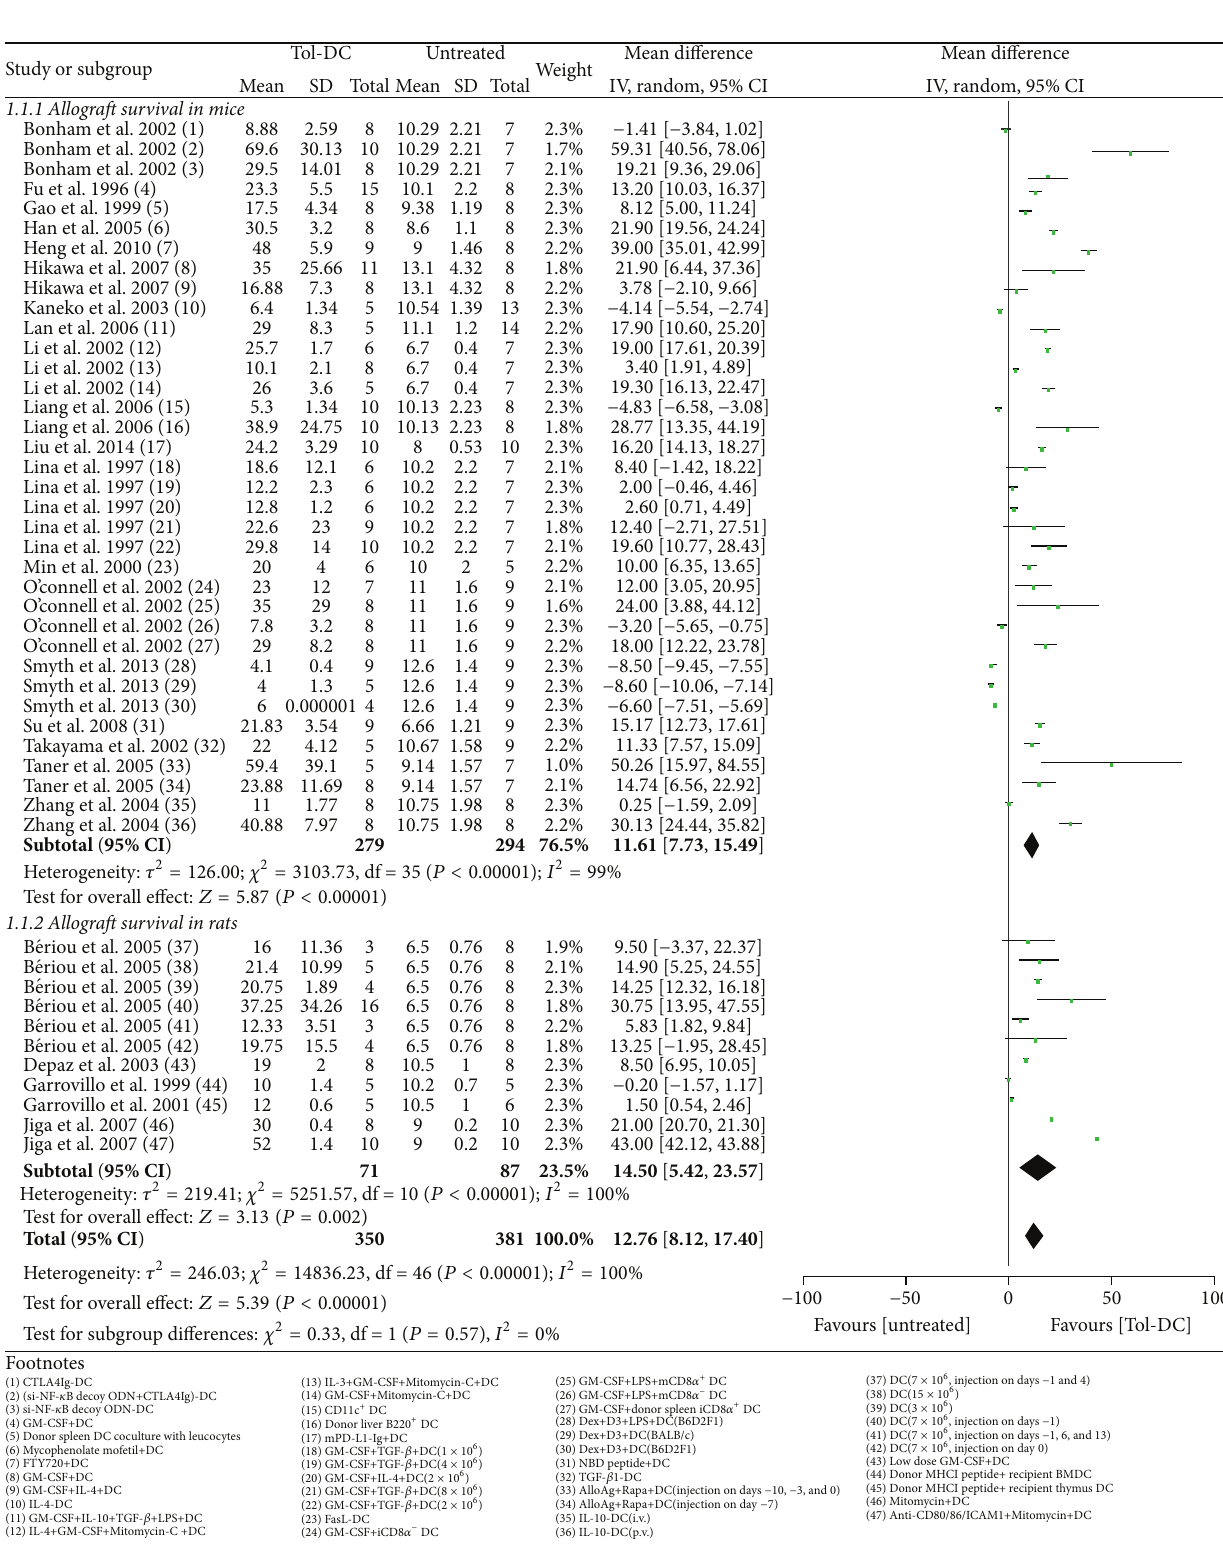
Figure 2: Mean difference (95% confidence intervals) for Tol-DC infusion versus untreated groups for allografts survival in heart. All studies involved used MHC complete mismatch models either in rats or in mice. In the footnotes, “ − ” before “DC” means genetic modification